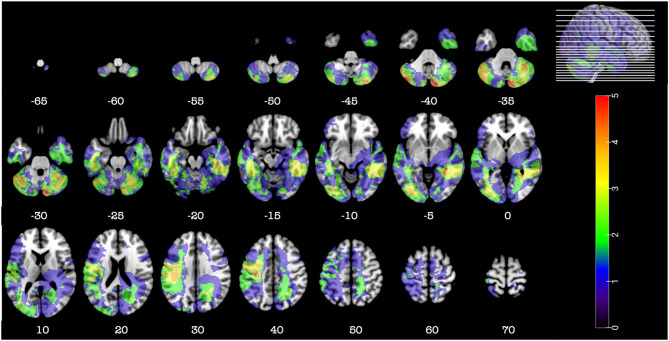
Representative axial slices depicting the lesion overlay density maps of TBI participants in the cerebellar group (n = 24). Z-values shown at the bottom of each slice indicate the z coordinates (MNI) of each axial slice represented in the 3D view of the brain by white line. The color indicates the number of veterans in the group with damage to a given voxel. Images are in radiological space (i.e., right is left).